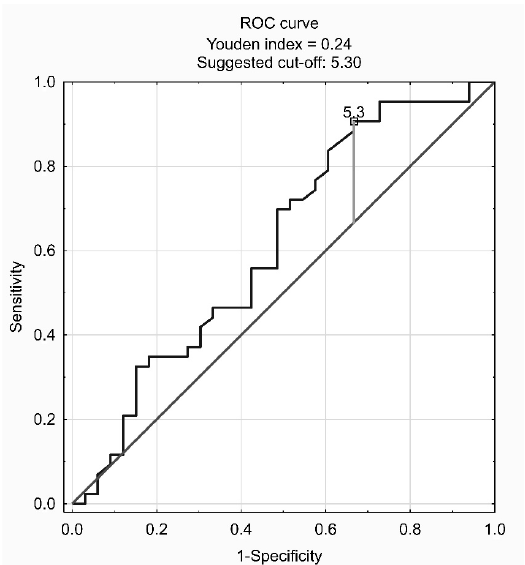
Figure 2. Receiver operating characteristic curve (ROC) suggesting the optimal apnea–hypopnea index (AHI) cutoff point for indicating its suitability to recognize bruxism (BEI ≥ 2) in the group with AHI < 30.